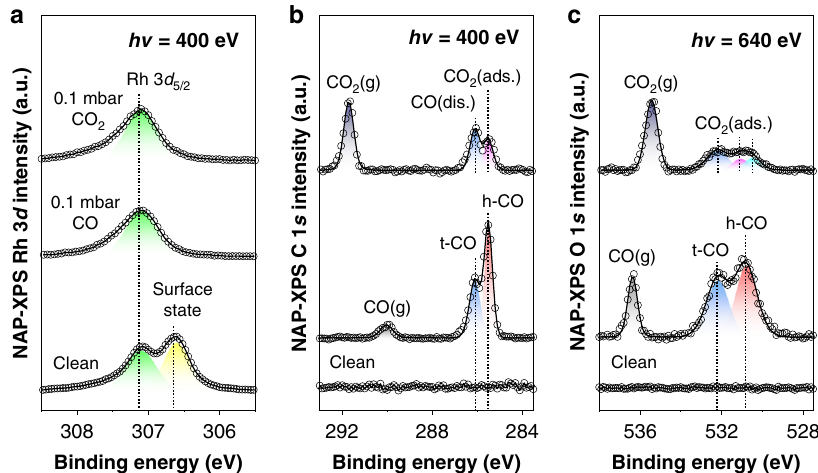
Fig. 2 Chemical binding energy analysis for adsorbed CO and CO 2 molecules. a − c Synchrotron-radiation NAP-XPS measurements for Rh 3 d ( h ν = 400 eV) ( a ), C 1 s ( h ν = 400eV) ( b ) and O 1 s ( h ν = 640 eV) ( c ) core-level spectra under UHV, 0.1 mbar CO and 0.1 mbar CO 2 environments. The metallic Rh 3 d 5/2 core-level and non-perturbed surface state of Rh atoms deconvoluted with green and yellow peaks, respectively. Site-speci fi c molecular CO bound properties of t-CO (blue) and h-CO (red) indicated in both of C 1 s and O 1 s core-level spectra. Chemical binding features of dissociative adsorption for CO 2 at the interface also resolved individually with colors of blue, magenta and cyan,